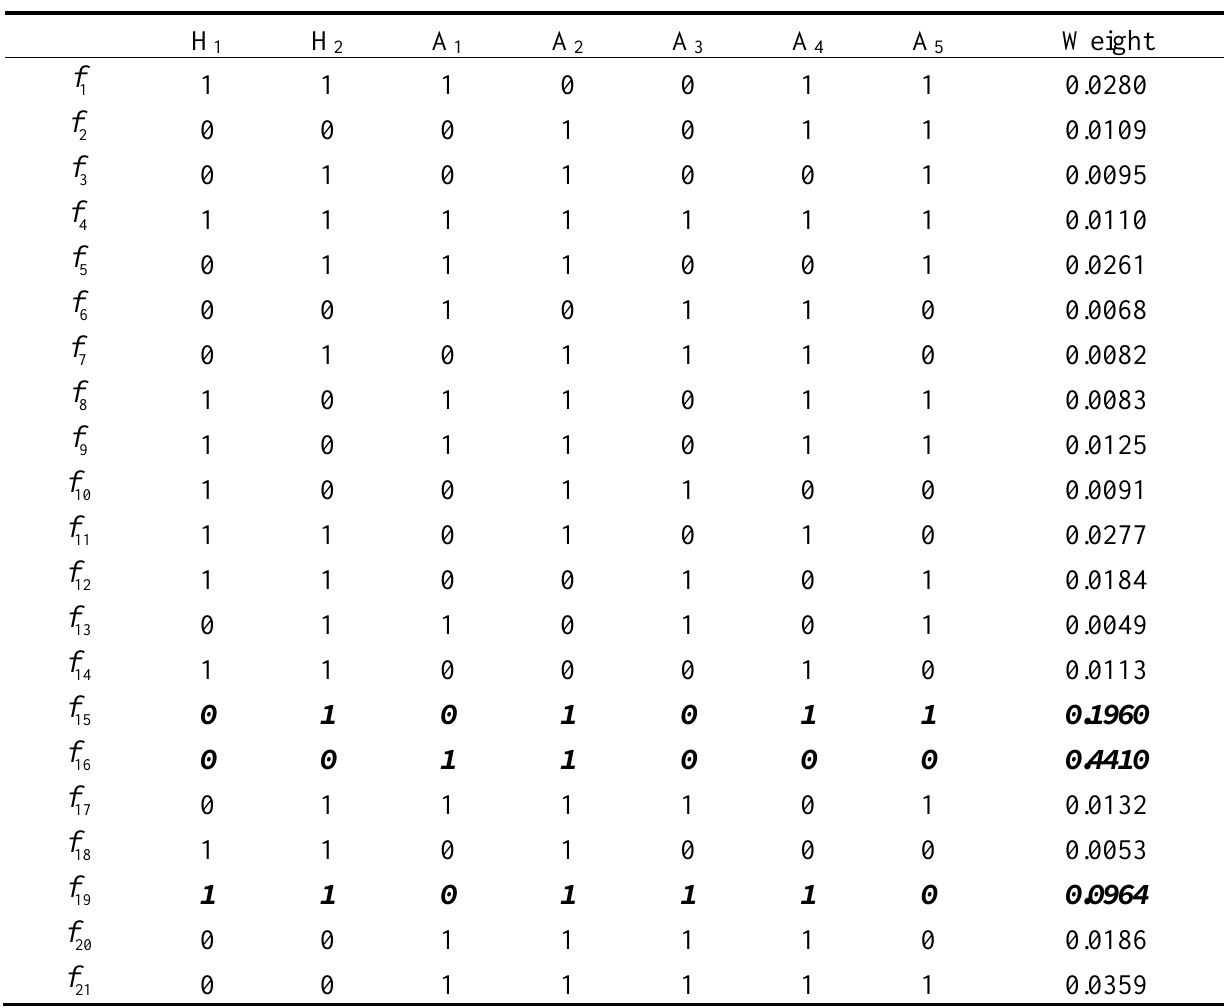
Table 5. Encoded chromosome individual with the best fitness on k-NN, noting that